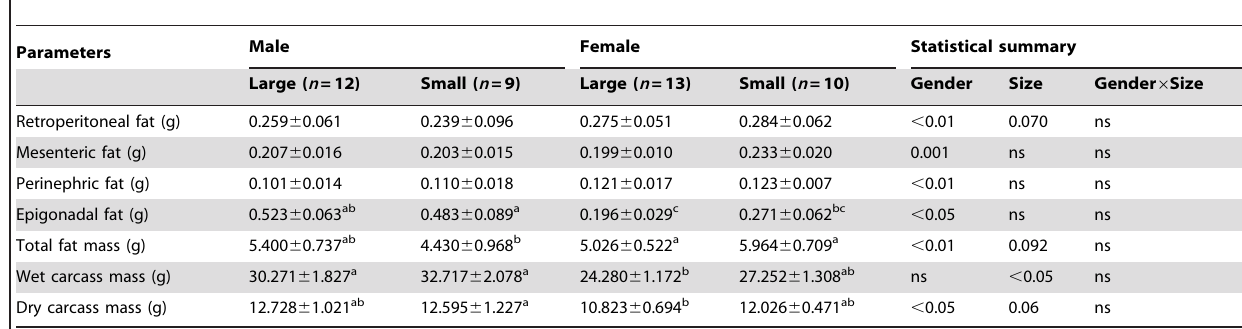
Table 4. Fat pads and carcass mass in adult male and female offspring from large and small litters.